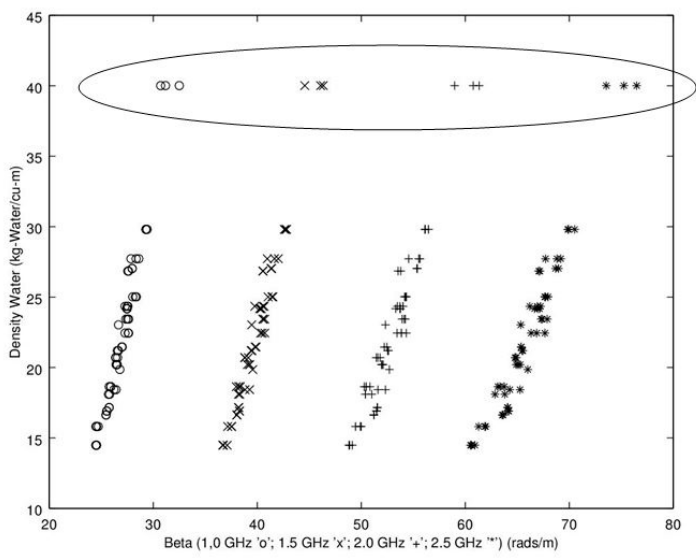
Figure 18. Propagation delay constant, β , versus bulk water density (kg_water · m − 3 ) at 1.0, 1.5, 2.0 and 2.5 GHz. Of note is the much higher correlation than when β is compared to moisture content, thereby further illustrating that the microwave energy is almost entirely impacted by the water alone, not the dry bulk material. The points circled are from the very wet low-density module. Note water density calculated from moisture content utilizing Equation 9.